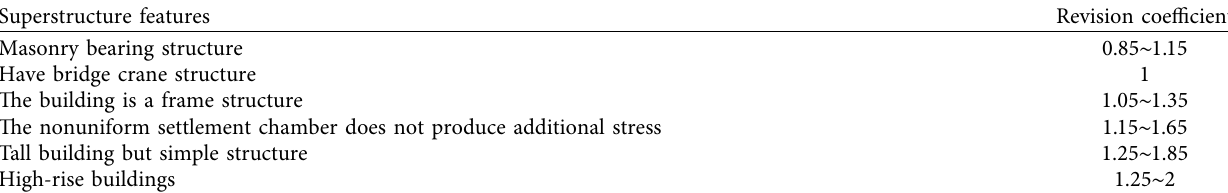
Table 4: Revision coefcient for stop grouting